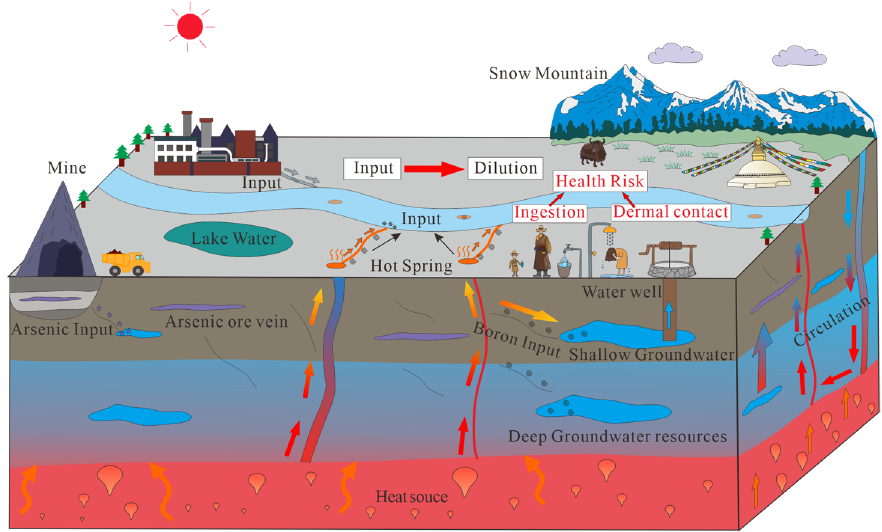
Figure 12. Schematic contamination model of geothermal water to surface water and shallow groundwater in Zhaxikang Area.